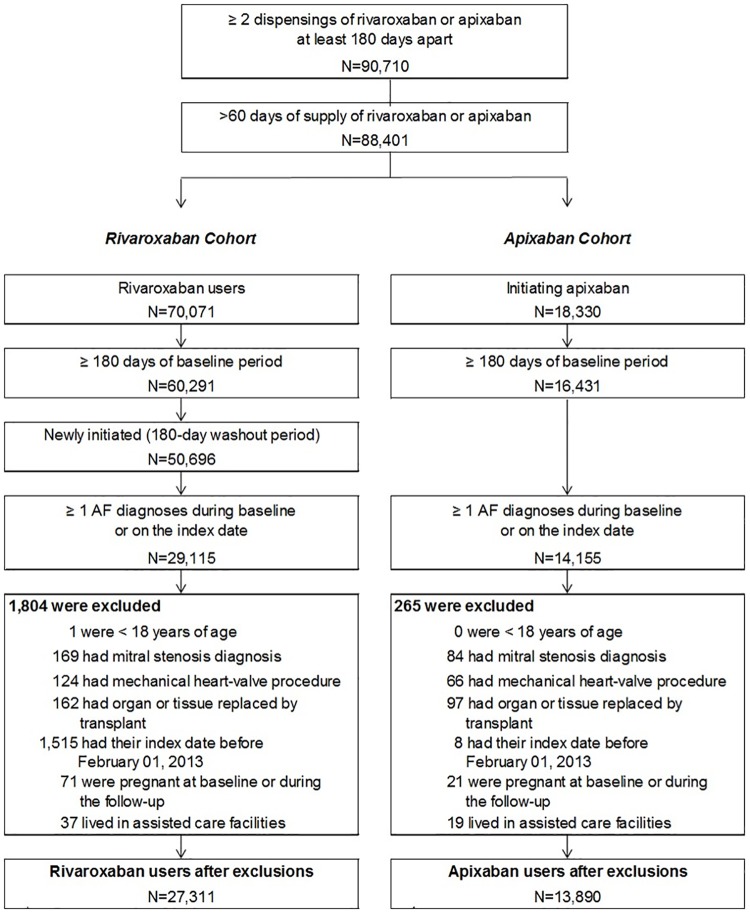
Sample selection.AF: atrial fibrillation.